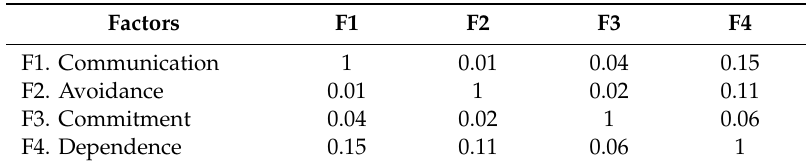
Table 4. Factor correlation matrix.